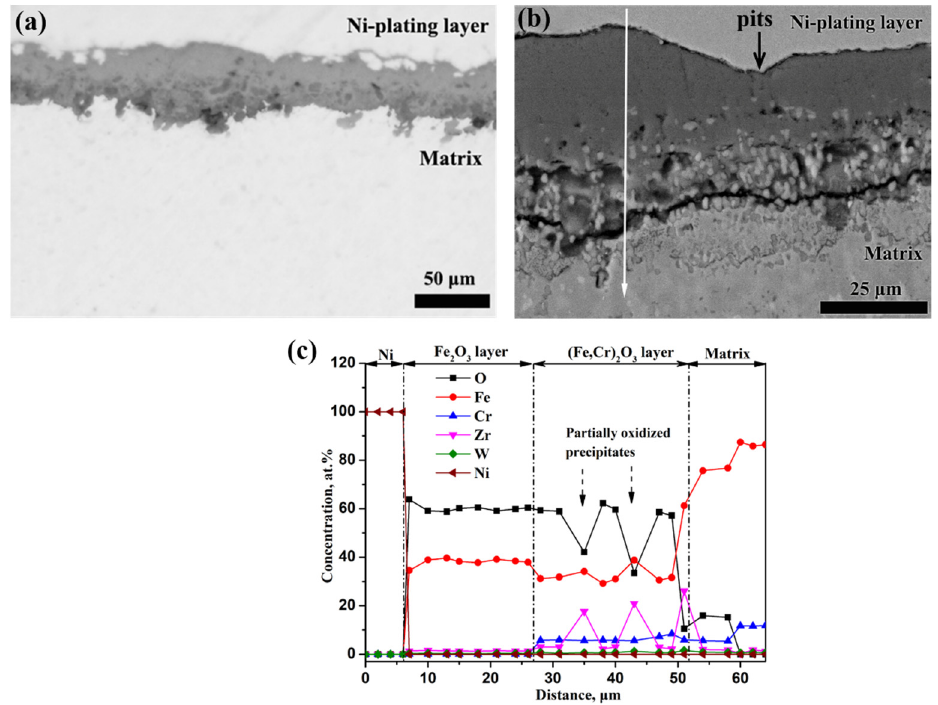
Figure 7. ( a ) OM and ( b ) BSE images of polished cross-sectional morphologies of Fe-Cr-Zr alloy after oxidation in air at 923 K for 1000 h. ( c ) Compositional profiles with the distance across the oxide scale marked in ( b ).